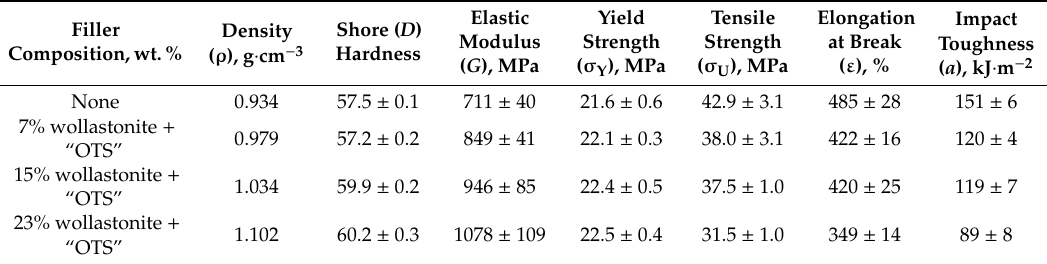
Table 4. The physico-mechanical properties of the neat UHMWPE and the UHMWPE-based composites silanized with the “OTS” coupling agent. Filler